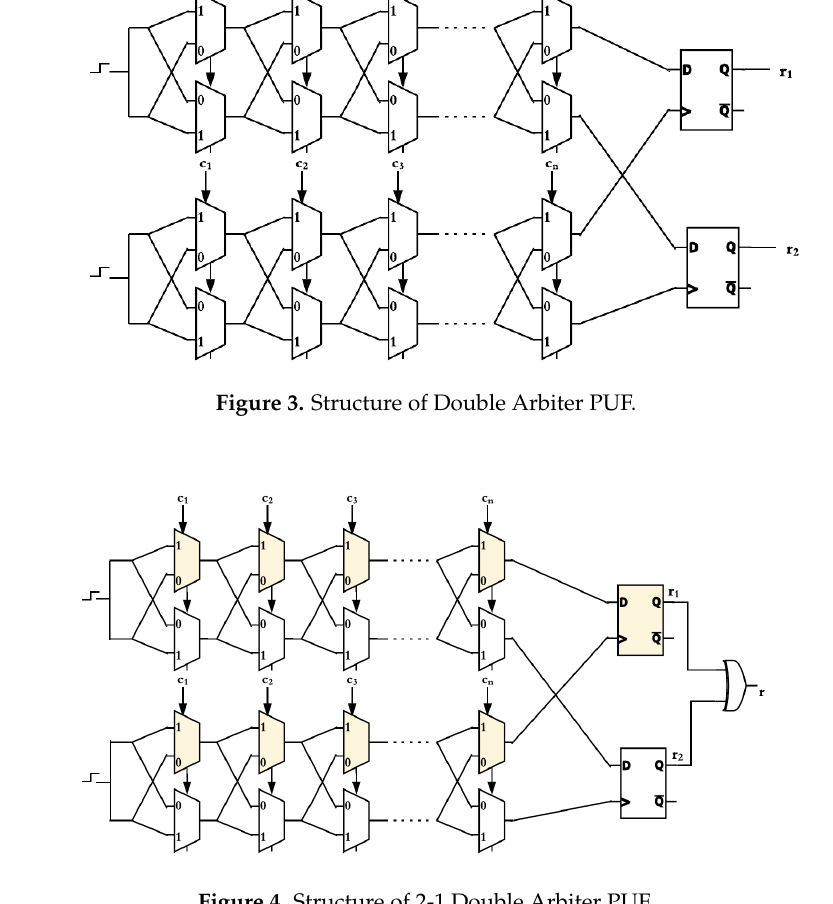
Figure 4. Structure of 2-1 Double Arbiter PUF.